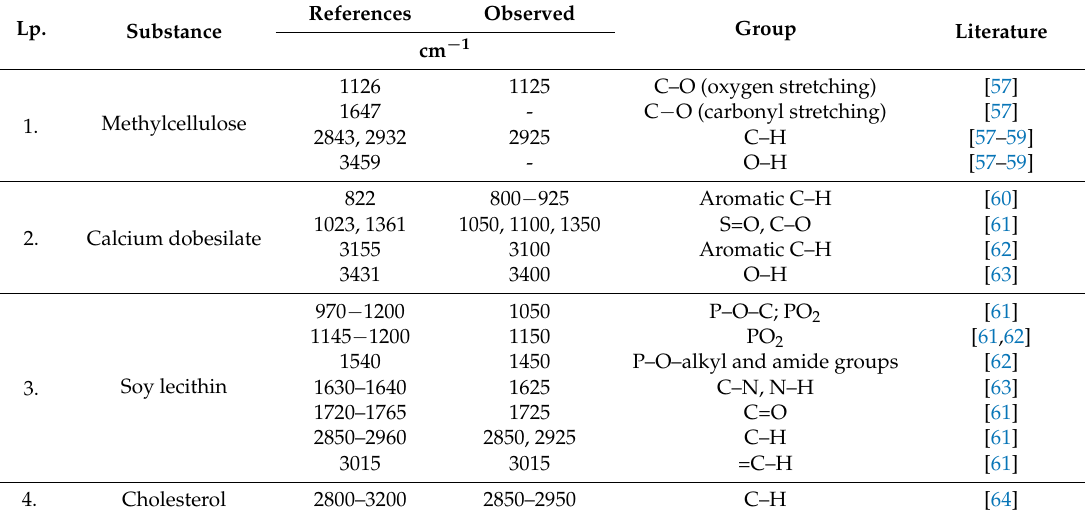
Table 3. Peaks in FTIR for clean